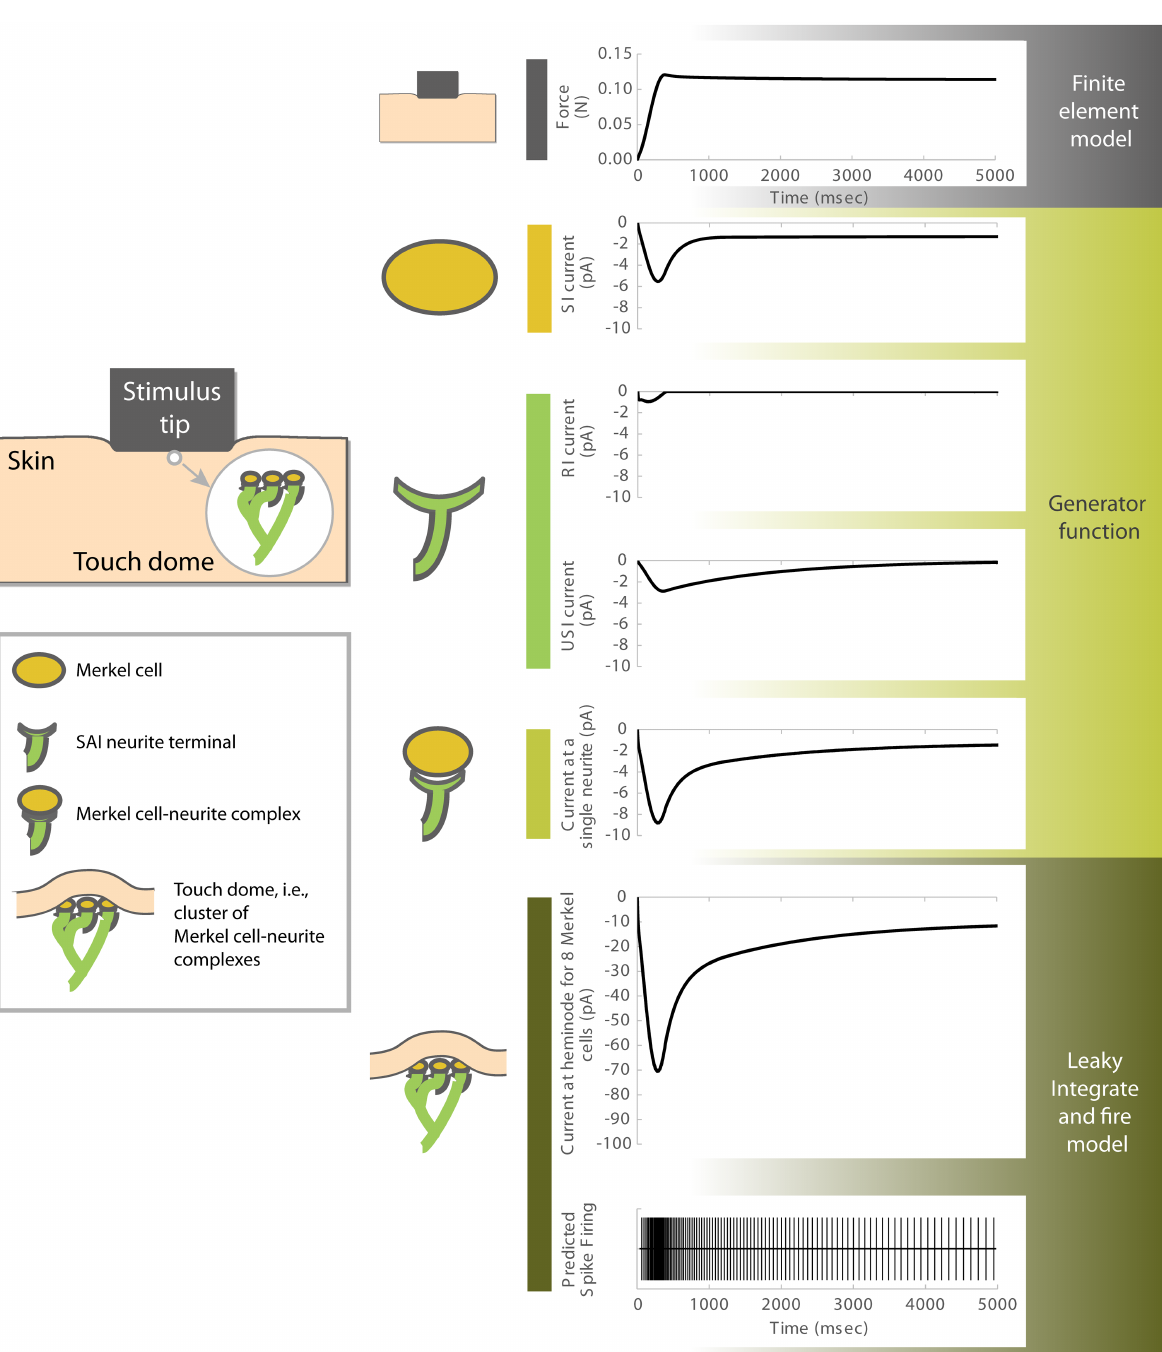
Figure 9. Schematic representation of multiscale model of Merkel cell-neurite complexes. The top panel on the right shows the stimulus applied to the skin. SI and USI represent the slowly–activating current arising from the Merkel–cell and the ultra–slowly–inactivating from the neurite terminal. The generator function includes the three currents and the compressive stress and uses as input the compressive stress calculated from the stimulus force (top panel) through a finite–element model. The simulated currents for a single Merkel–cell are summed to obtain a heminode constituted by eight Merkel–cell neurite complexes. Reproduced from [221] under the CC BY